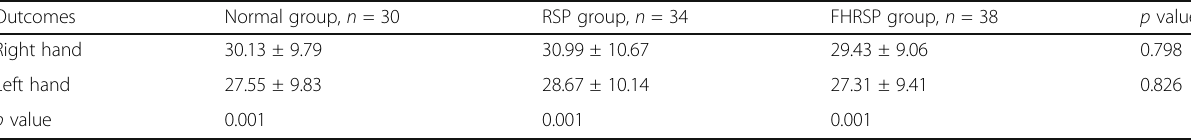
Table 2 The effect of hand side on hand grip strength (kg)